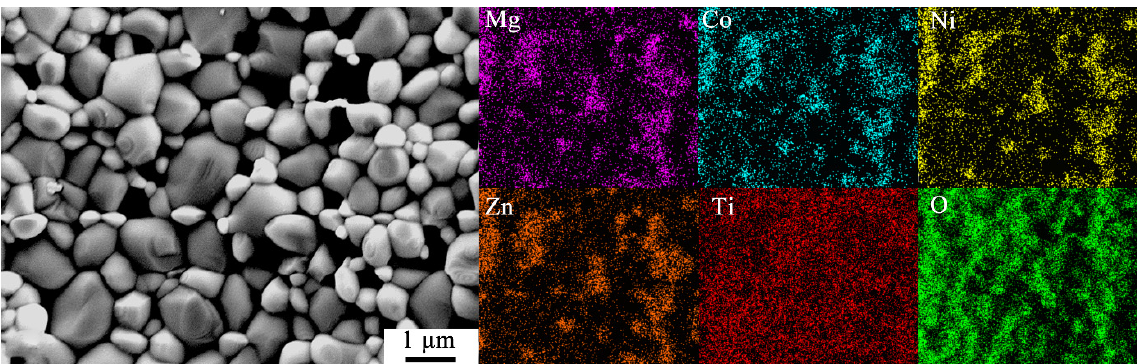
Fig. 3 SEM image and corresponding EDS mappings of AT2 after sintering at 1100 ℃ .